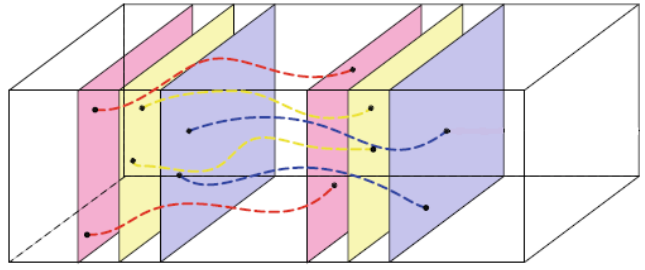
Figure 7. Trajectories between successive